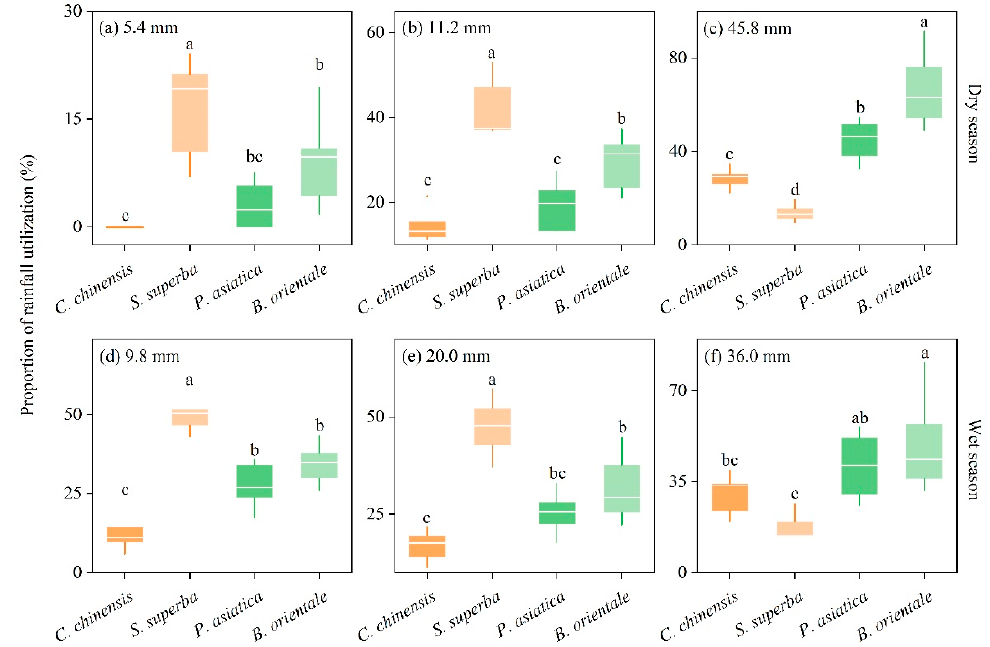
Figure 3. Changes in the proportion of precipitation utilized by the four PFTs after different magni- tudes of rainfall events in the dry ( a – c ) and wet ( d – f ) seasons in the monsoon evergreen broad-leaved forest. The whiskers illustrate the 5th and 95th percentiles, and the ends of the boxes represent the 25th and 75th quartiles (interquartile range). Different letters indicate significant differences at p < 0.05.